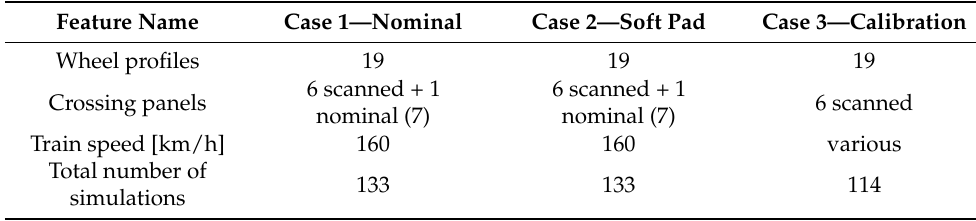
Table 5. Summary of operational conditions studied in the